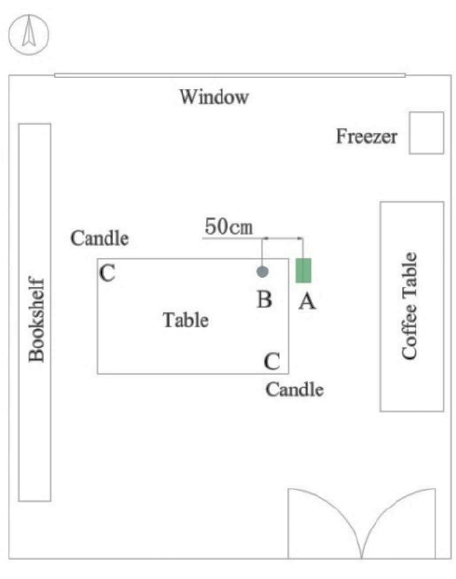
Figure 5. Schematic drawing of the experimental setup.